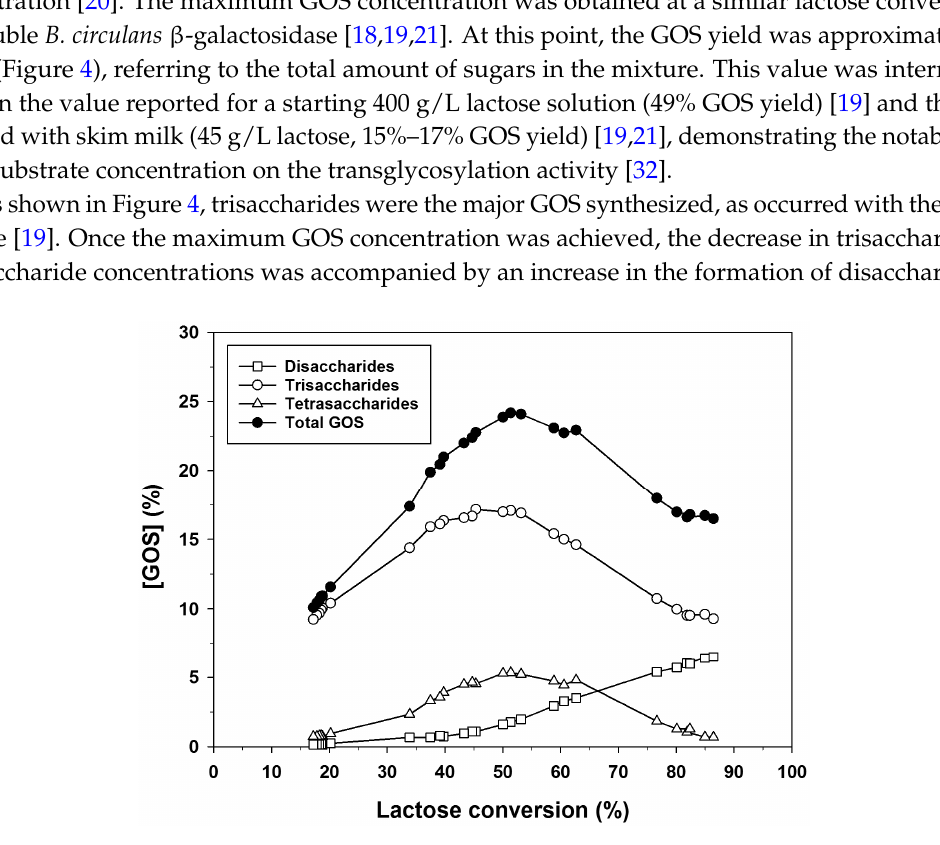
Figure 4. Effect of lactose conversion on GOS (galactooligosaccharides) yield and product distribution by B. circulans β‐ galactosidase immobilized on glyoxal agarose beads. Conditions: 100 g/L lactose, 0.1 M acetate buffer (pH 5.5), 45